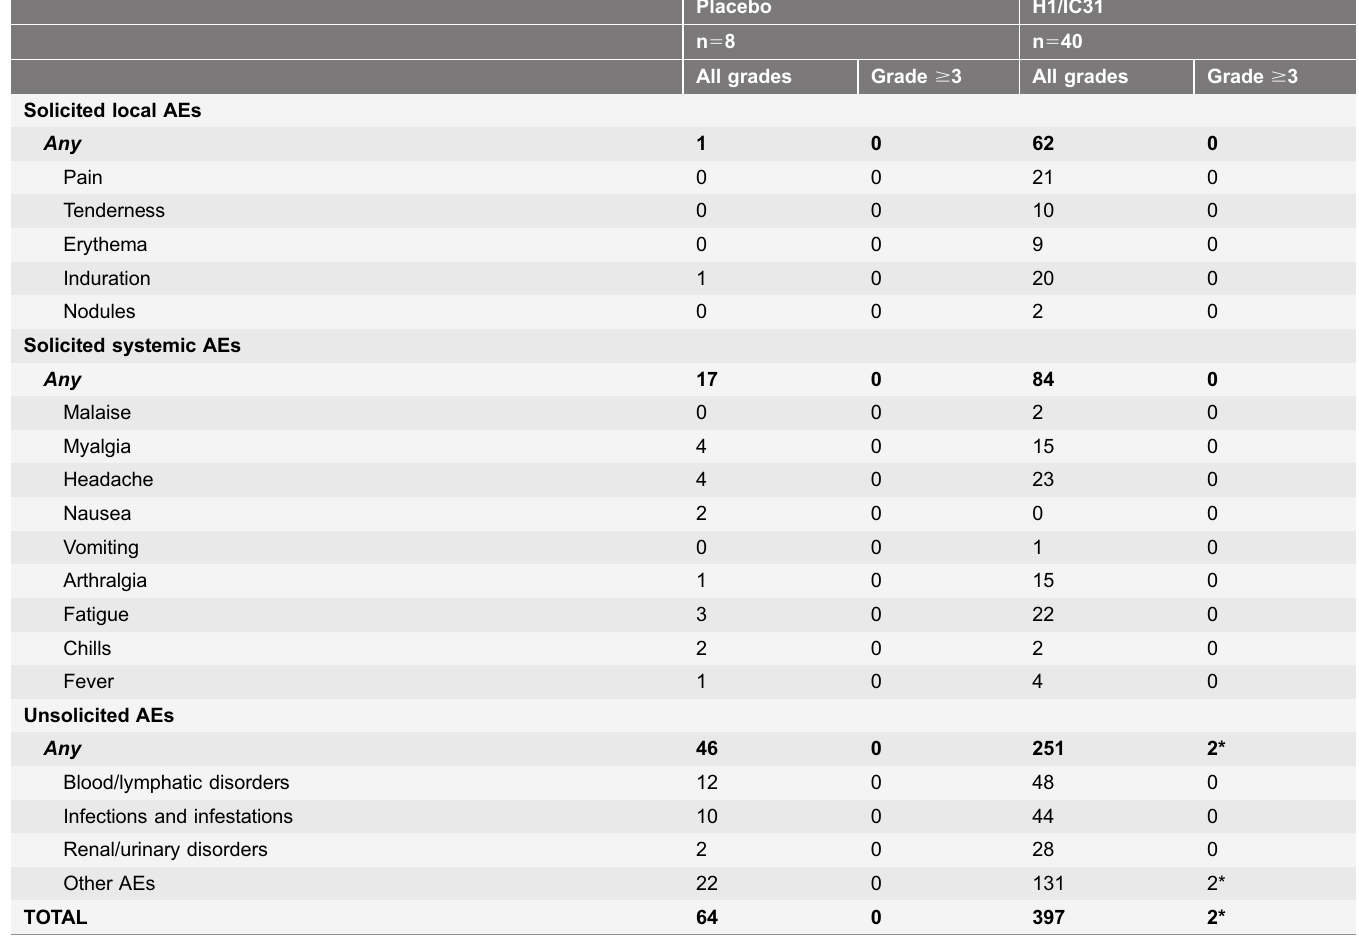
Table 2. Adverse events (AEs) during trial period (day 0–182) by vaccination